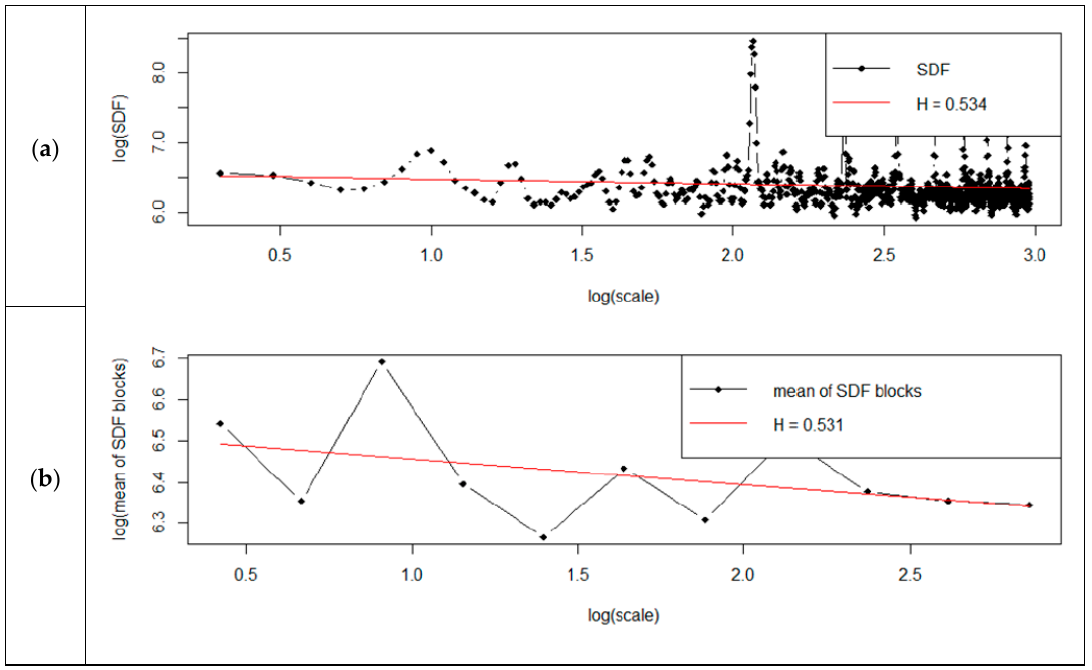
Figure 11. Spectral regression graph by the direct method: ( a ) the standard method, ( b ) the smoothed method.